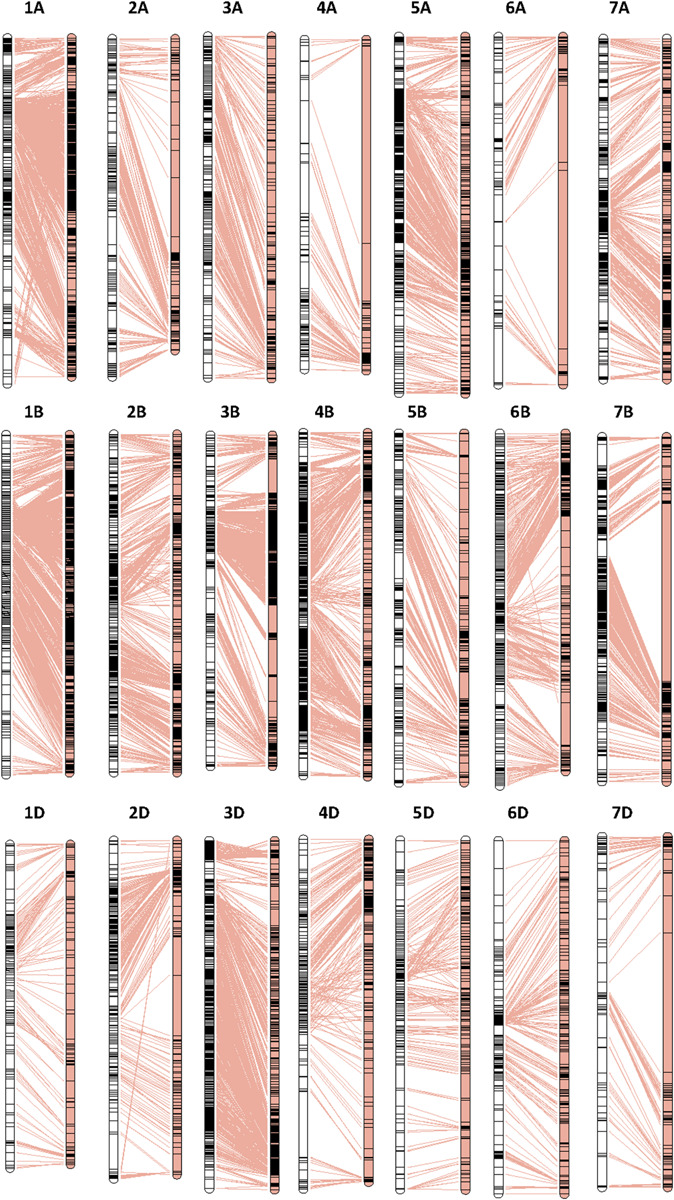
High-density genetic map construction based on SLAFs and collinearity analysis of the SLAFs between the genetic map and the physical map. The left and right panels represent the genetic map and the physical map, respectively.